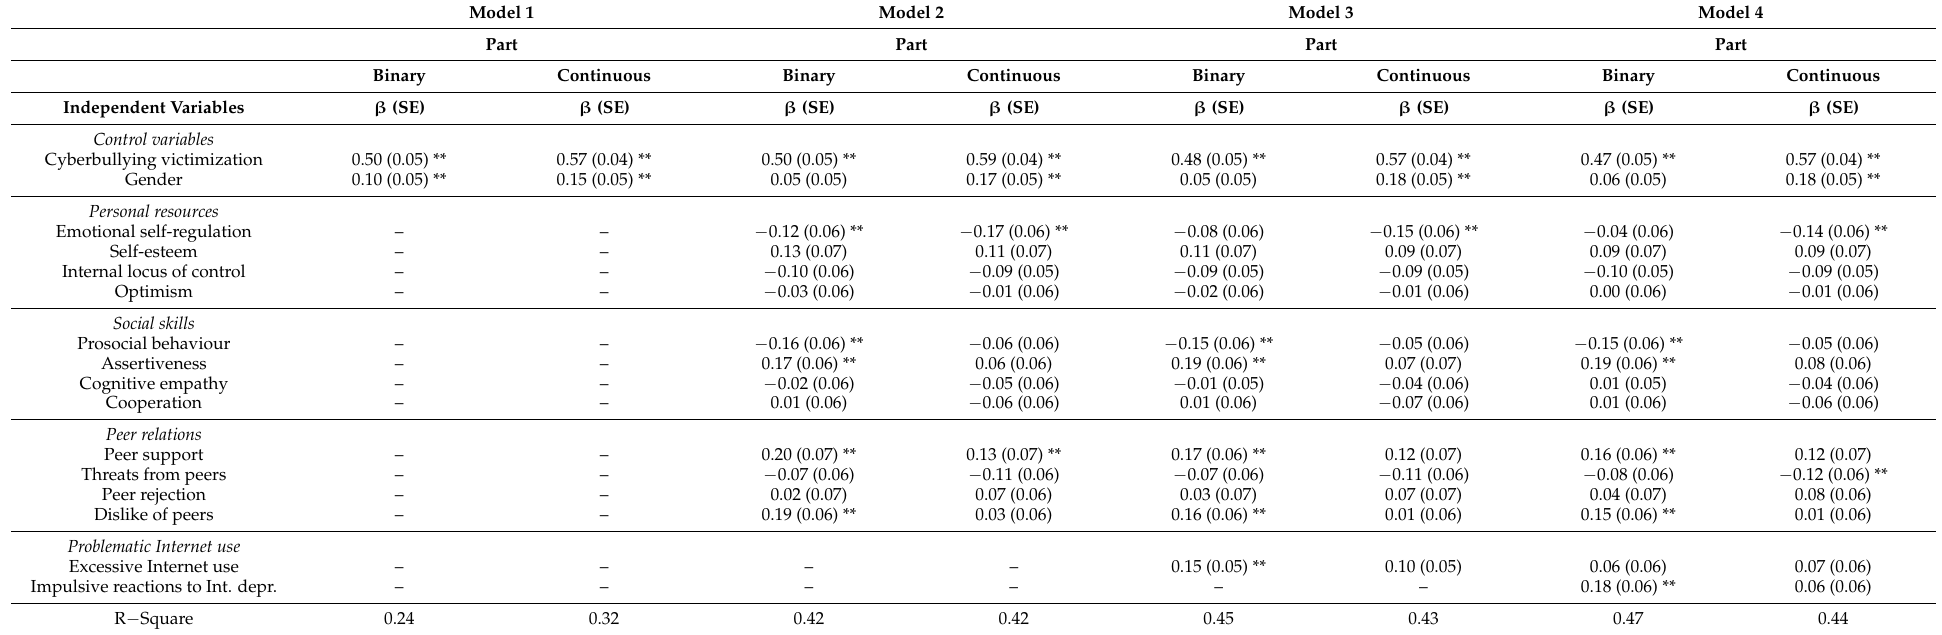
Table 5. Predictors of cyberbullying. Two-part regression